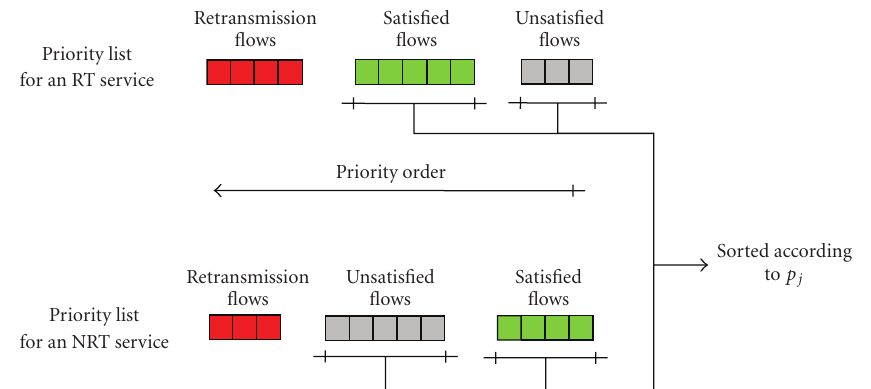
Figure 3: Priority lists for RT and NRT services. The prioritization takes into account the retransmission status, satisfaction level and a per-flow priority.